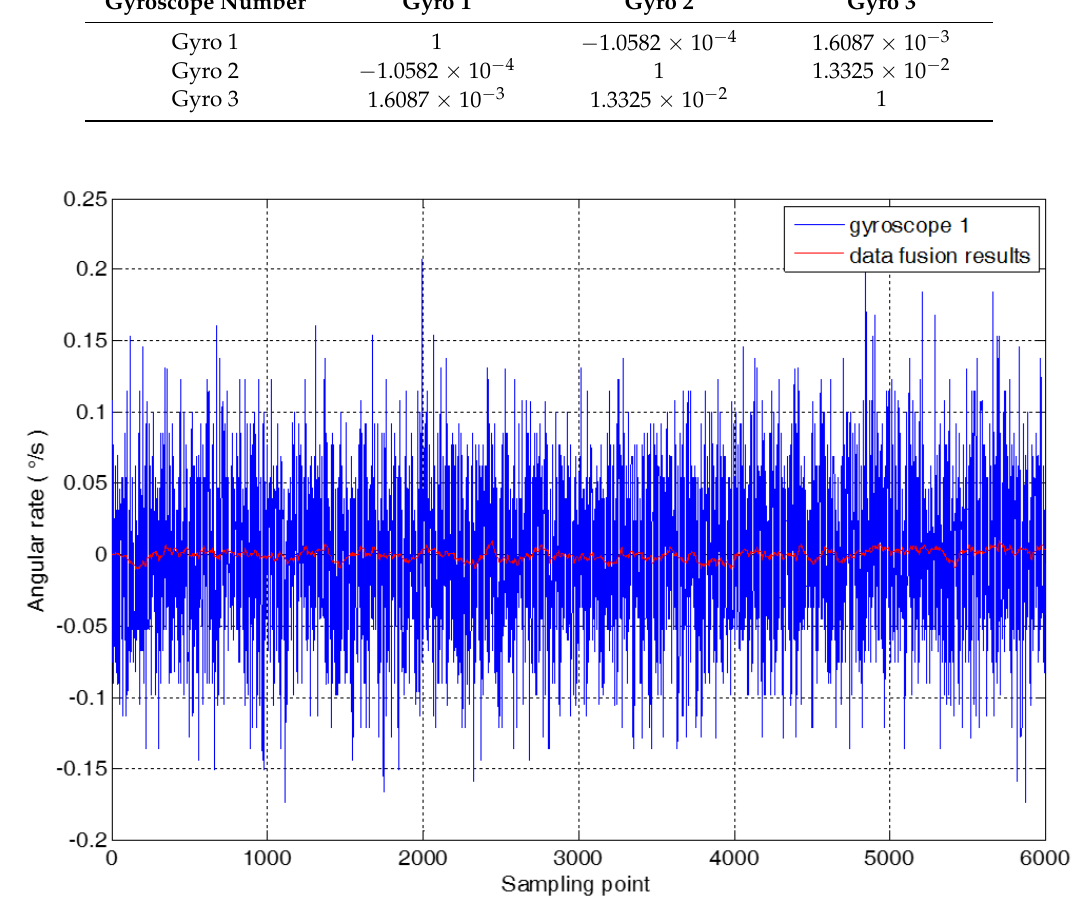
Figure 5. The results of random drift and data